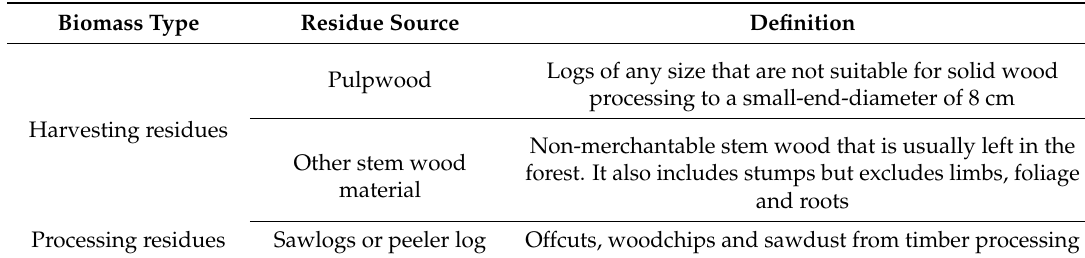
Table 1. Definition of forest biomass